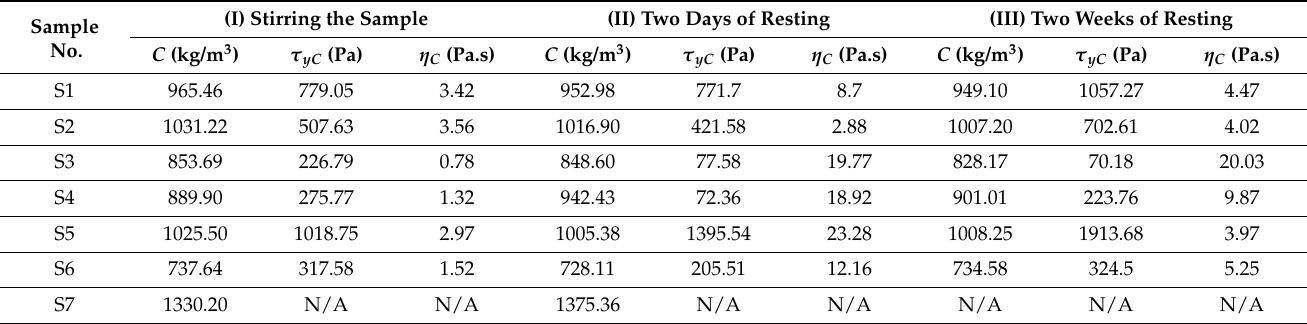
Table 5. Casson yield stresses and viscosities for all samples for three steps.